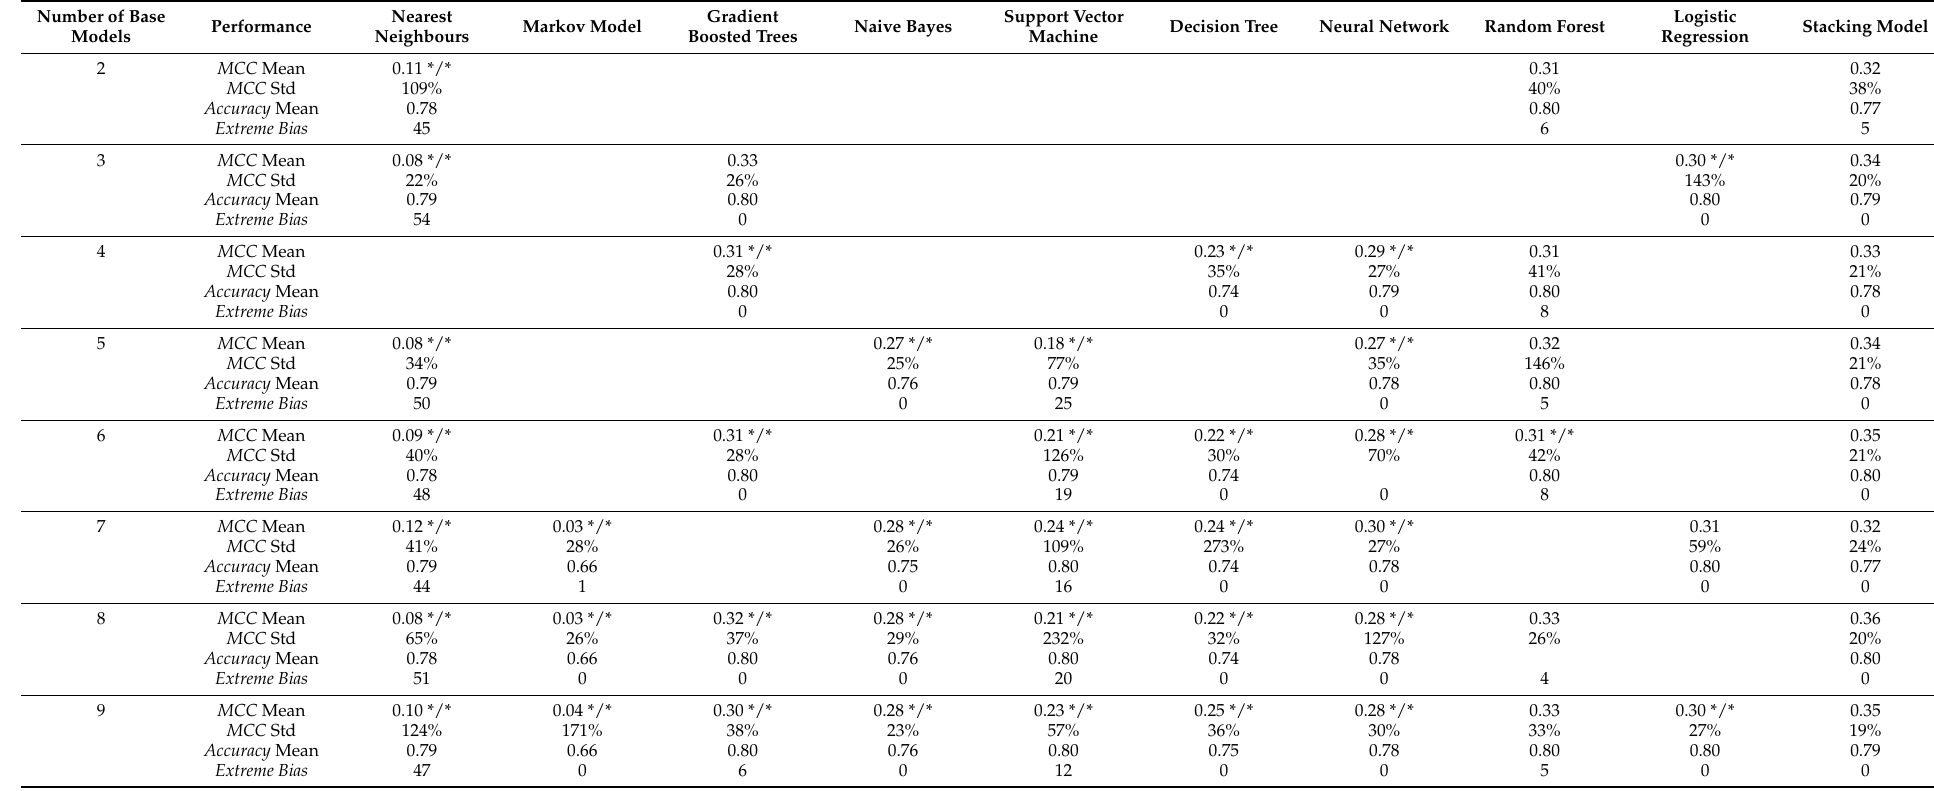
Table 3. Modeling Results for Taiwanese Credit Card Clients